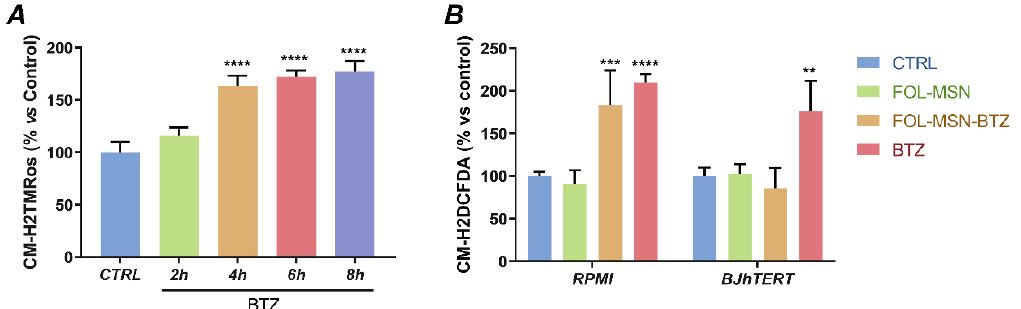
Figure 6. ROS species as mediators of BTZ-induced toxicity. ( A ) Time course assessment of ROS levels in FR+ RPMI-8226 (RPMI) cells treated with free BTZ (0.1 μg/mL). ( B ) Intracellular ROS levels were analyzed in RPMI MM cells and in FR- BJhTERT normal cells after treatment with MSN-FOL (negative control), FOL-MSN-BTZ and free BTZ (positive control). Untreated cells were used as negative control. Values represent the mean of three triplicate independent experiments. Data are shown as probe fluorescence normalized on viable cell number and expressed as percentage vs. negative